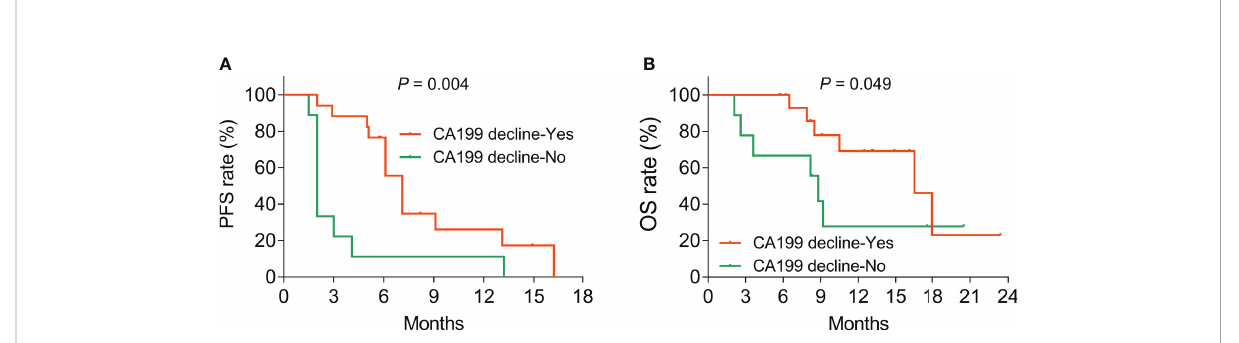
FIGURE 5 CA199 decline was linked with increased PFS and OS rates in BTC patients. Correlation of CA199 decline with PFS (A) and OS (B) rates in BTC patients.